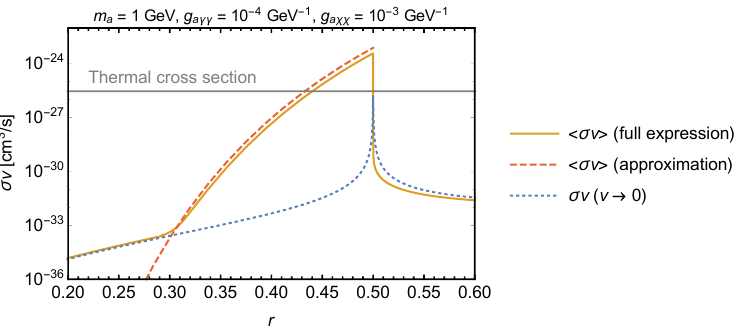
Figure 3 . Comparison of the thermally averaged annihilation cross section h (cid:27)v i (orange, solid) and the annihilation cross section in the limit v ! 0 (blue, dotted) as a function of the mass ratio r = m (cid:31) =m a for m a = 1 GeV and g a(cid:13)(cid:13) = 10 (cid:0) 4 GeV (cid:0) 1 . The red dashed line indicates the simpli(cid:12)ed expression from eq. (4.6), which is valid close to the resonance. Away from the resonance the cross section depends also on the ALP-DM coupling, which has been set to g a(cid:31)(cid:31) = 10 (cid:0) 3 GeV (cid:0) 1